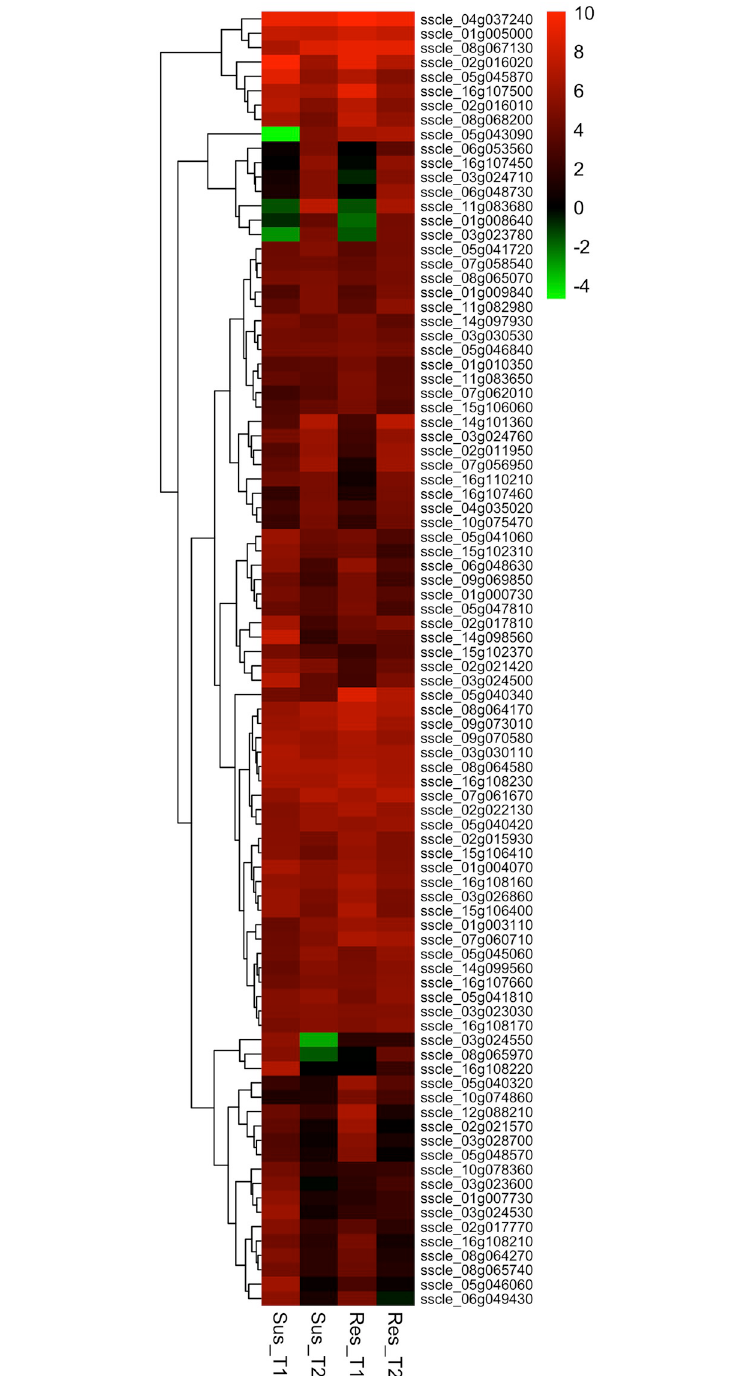
Fig 4. Heat maps showing expression patterns of the top 50 highly up-regulated Sclerotinia sclerotiorum genes from each treatment. Genes are grouped according to hierarchical clustering based on their expression patternsT1 and T2 represents earlier (8 and 16 hpi) and later (24 and 48 hpi) time points of interaction. The color gradient represents the log2 fold change in gene expression (up-regulation (red), down-regulation (green), and no change (black)) compared to in vitro